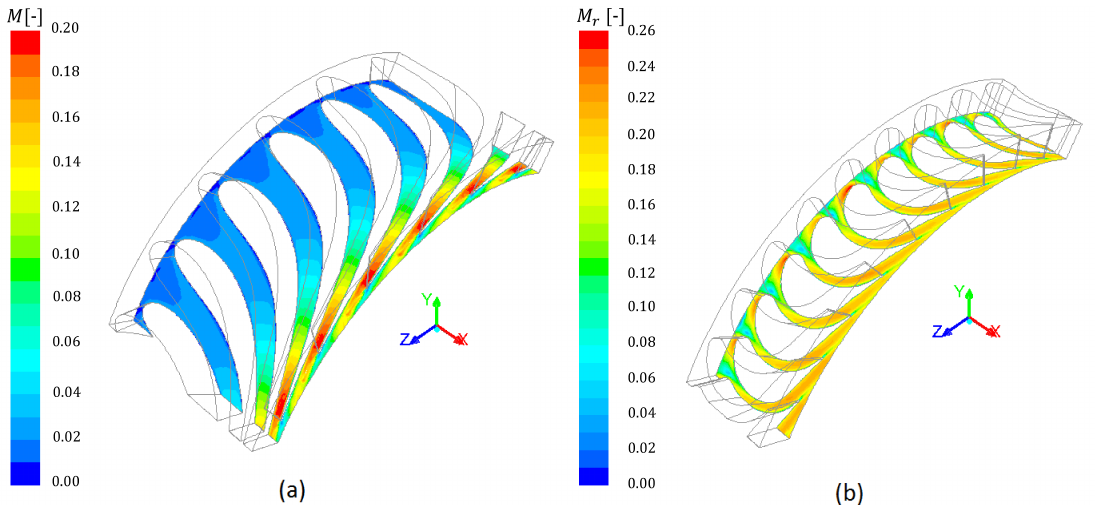
Figure 13. ( a ) Contours of Mach number at stator hub ( b ) Contours of relative Mach number at rotor hub.